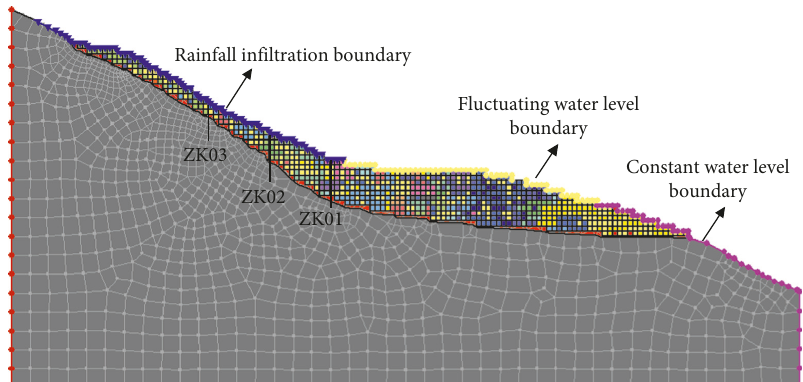
Figure 8: Meshed elements and presupposed boundary condition of the calculation model in